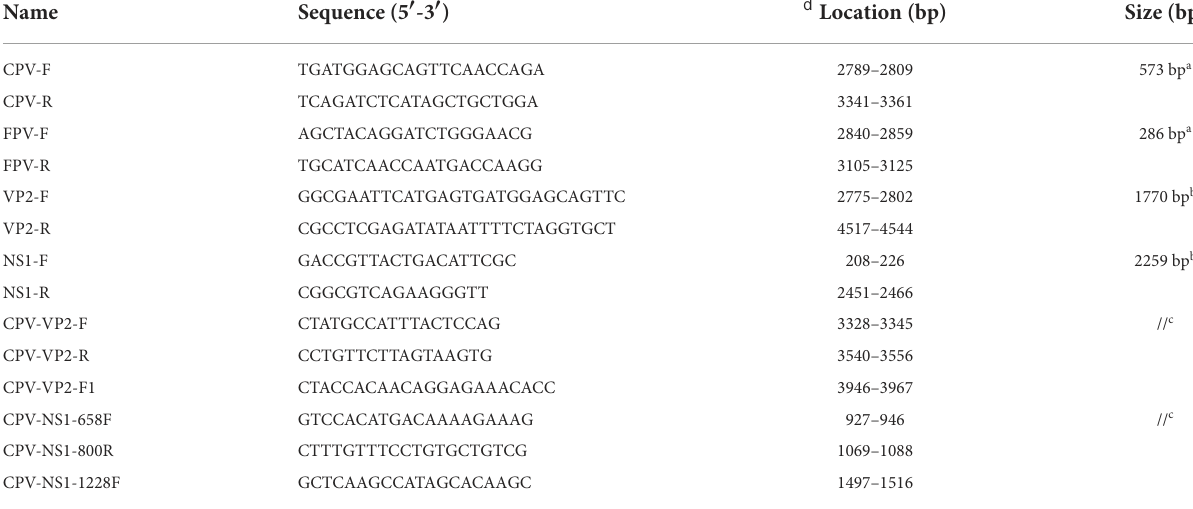
TABLE 2 Primers used in this study.